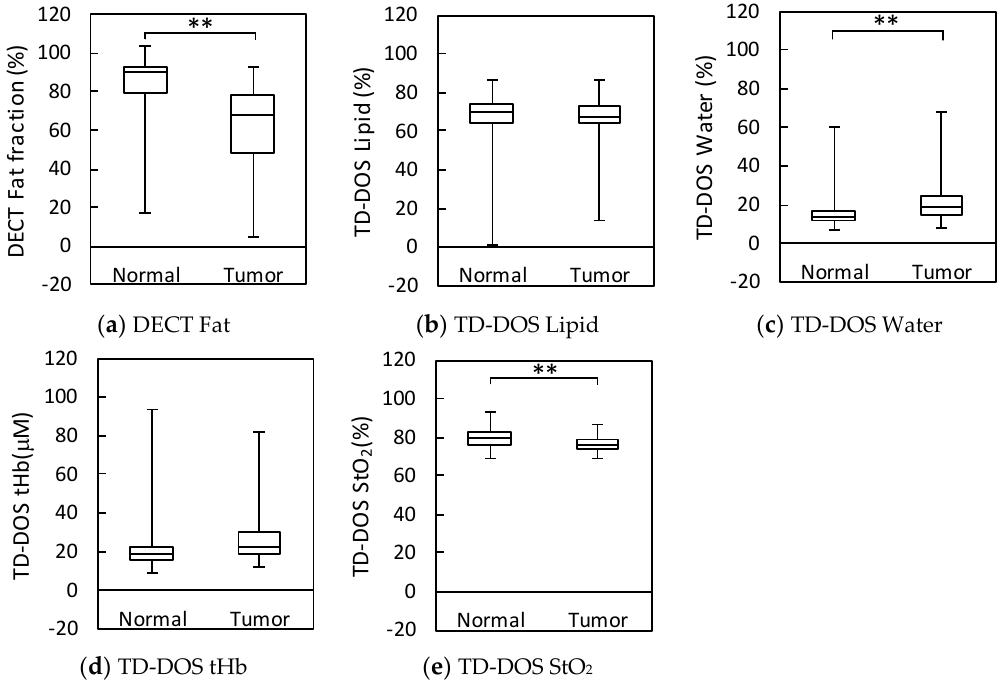
Figure 6. Box plots of parameter measurements by DECT and TD-DOS in normal and tumor tissues. (n = 16) ( a ) Fat fraction by DECT. ( b ) Lipid content by TD-DOS. ( c ) Water content by TD-DOS. ( d ) tHb by TD-DOS. ( e ) StO 2 by TD-DOS, ** p < 0.01 by the Wilcoxon signed rank test. Boxplots show the median (horizontal lines within the boxes), 75th and 25th percentiles (upper and lower edges of the boxes, respectively), and maximum and minimum values (upper and lower bars, respectively).